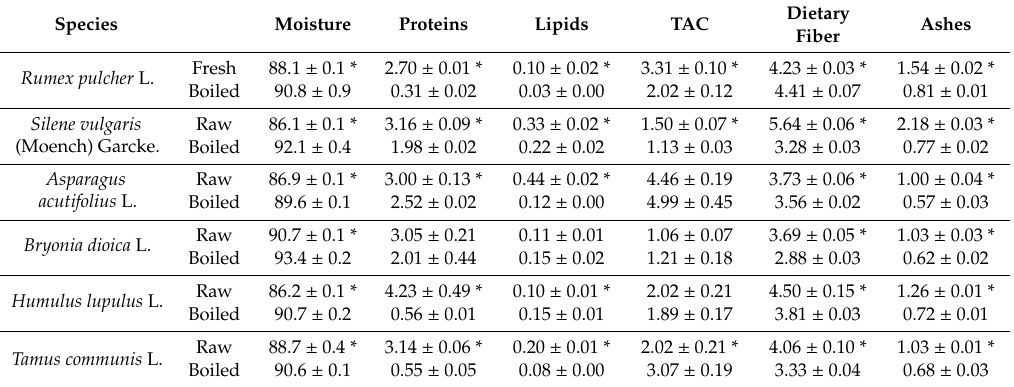
Table 3. Mineral macro-elements in raw and boiled wild vegetables (mg / 100 g fresh weight). Species Rumex pulcher L. Silene vulgaris (Moench) Garcke. Asparagus acutifolius L. Bryonia dioica L. Humulus lupulus L. Tamus communis L.